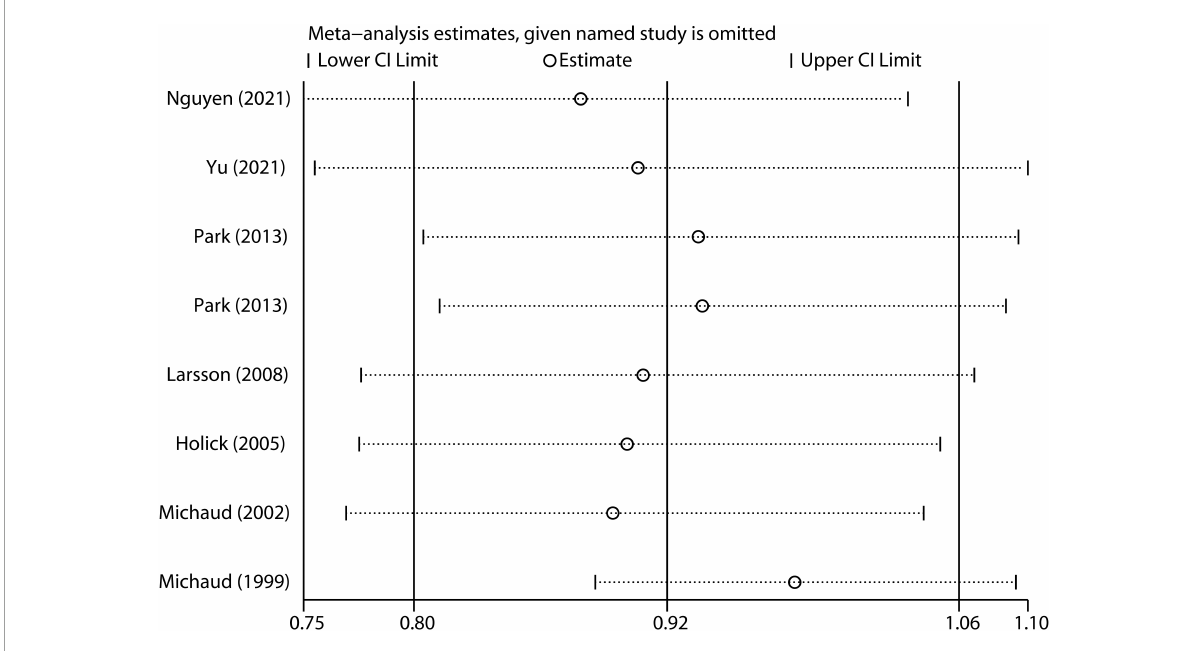
FIGURE4 Sensitivity analysis of included studies.